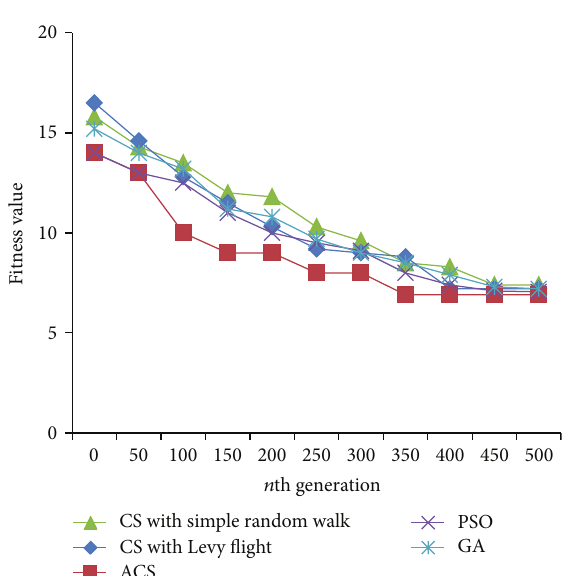
Figure 5: Average execution times (LUBM dataset).